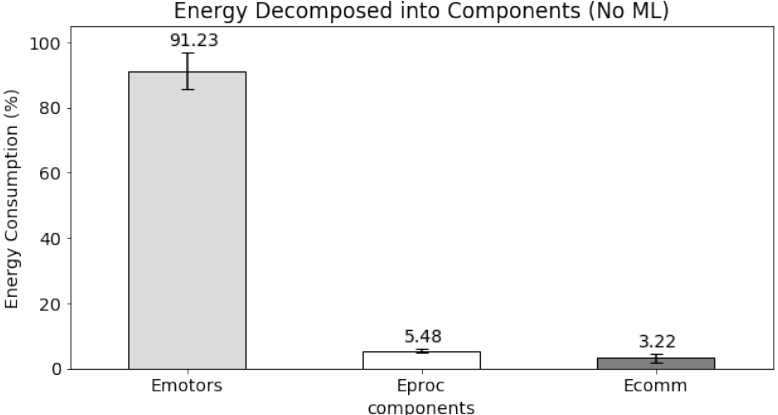
Figure 5. Energy decomposed into components (No ML).